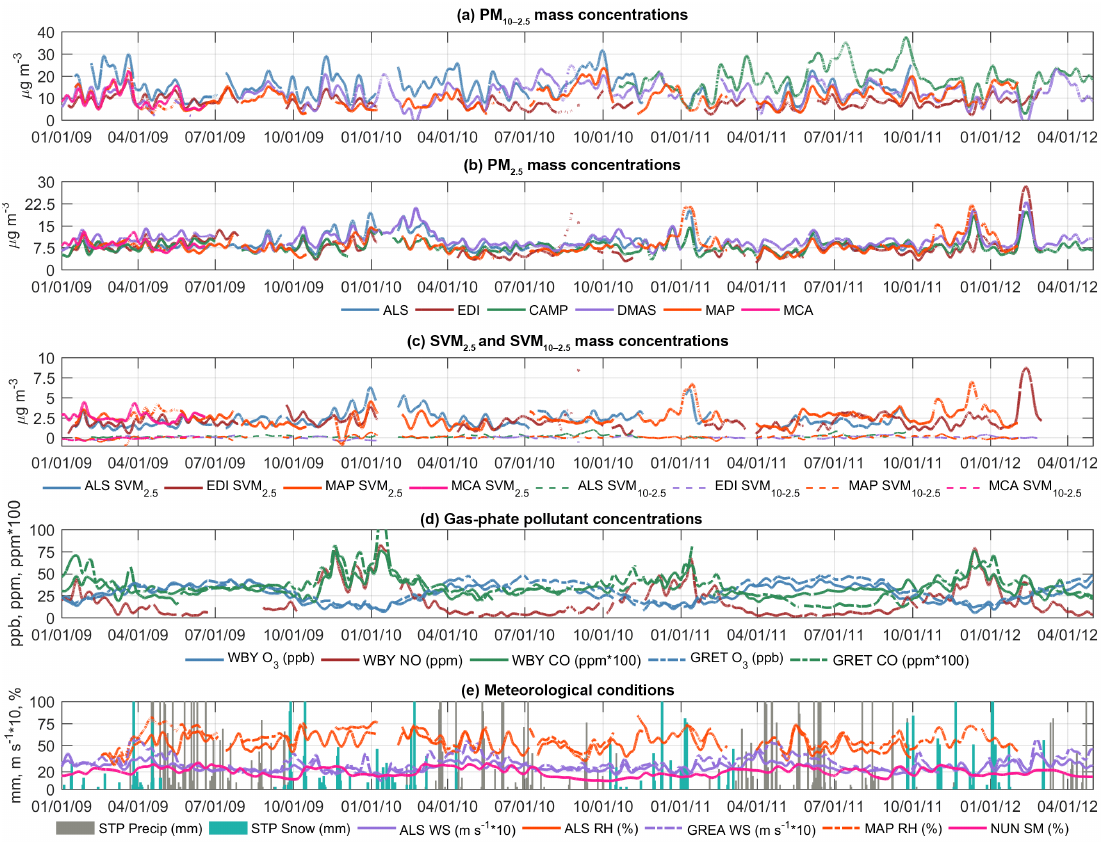
Figure 1. Smoothed ( (cid:49)θ = 3h) time series of hourly average (a) PM 10 − 2 . 5 mass concentrations, (b) PM 2 . 5 mass concentrations, (c) SVM 2 . 5 and SVM 10 − 2 . 5 mass concentrations, (d) gas-phase pollutant concentrations, and (e) meteorological conditions (WS and SM stand for wind speed and soil moisture, respectively, precipitation and snowfall data sets are daily totals with no